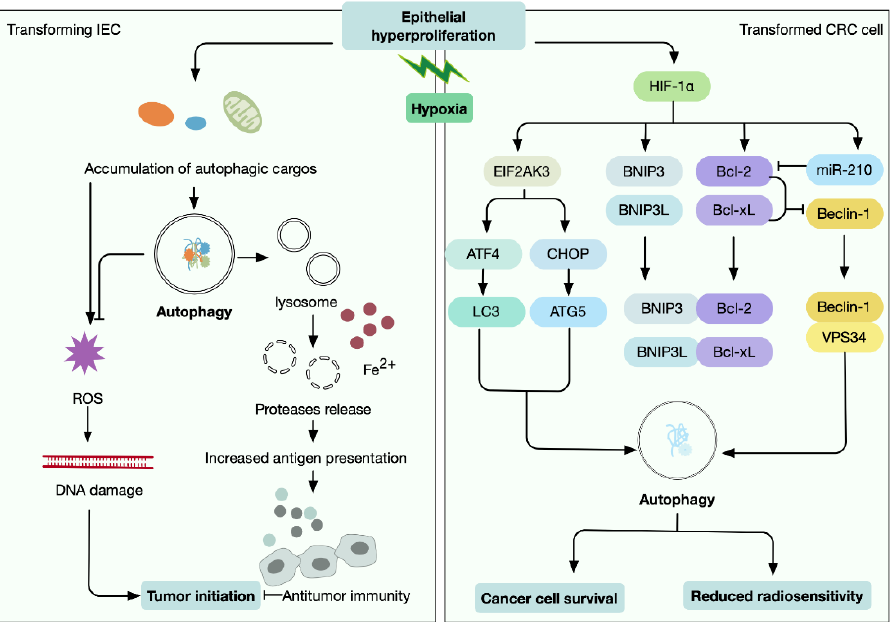
Figure 4. Autophagy coordinates cellular adaptation to hypoxia. Epithelial hyperproliferation results in a reduced level of oxygen, and dysregulated autophagy is involved in response to hypoxia. In transforming IECs, autophagy prevents cancer initiation via the elimination of hypoxia-induced accumulation of damaged cellular substances; while in transformed CRC cells, it promotes cancer cell survival by orchestrating multiple stress response pathways.